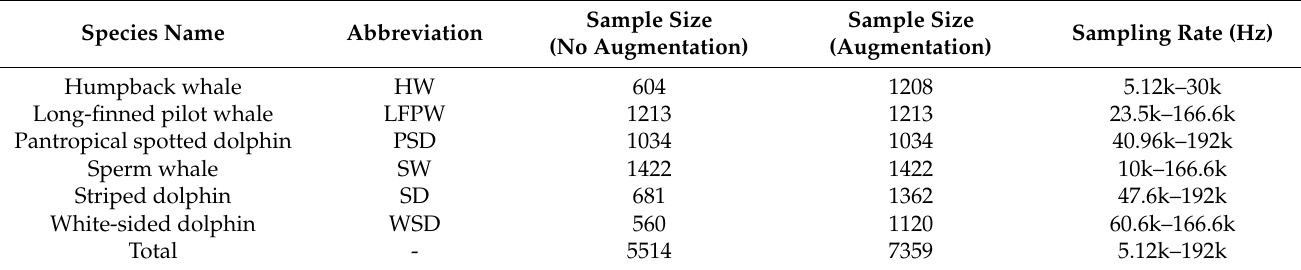
Table 1. Distribution and characteristics of samples.